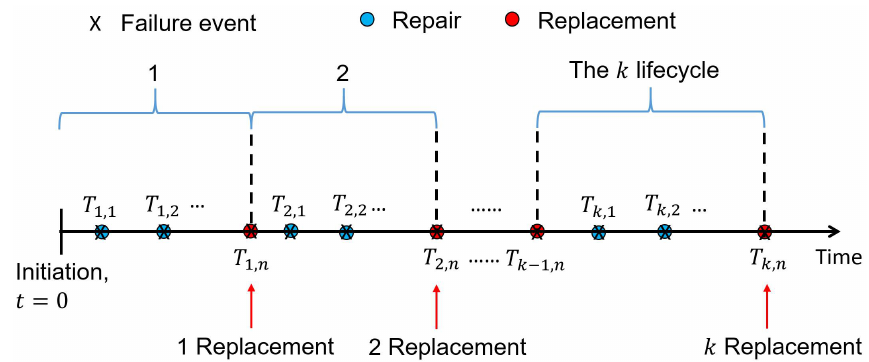
Figure 1. Concept of modelling failure events as a point process.